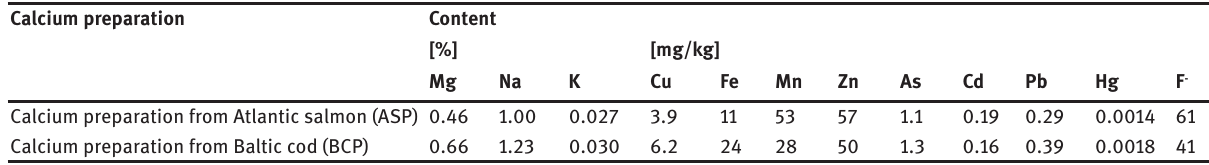
Table 4: Macro and microelements and undesirable elements content in the final calcium preparations. Calcium